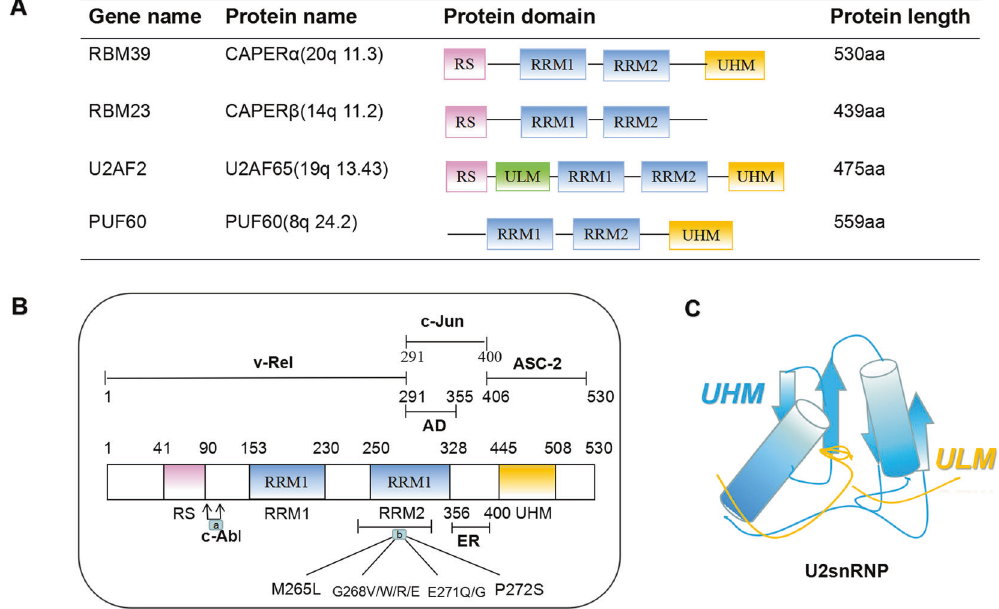
Fig. 1 The domain of RBM39 and its related proteins. A The domain composition of U2AF65 and its paralogous proteins . B Different functional domains of RBM39 (a. The interaction between c-Abl and RBM39, the phosphorylation site of RBM39; b. The toxic effect of indisulam, the mutation domain of indisulam gathers in the RRM2 domain of RBM39). C Schematic of the UHM – ULM-interaction structure.